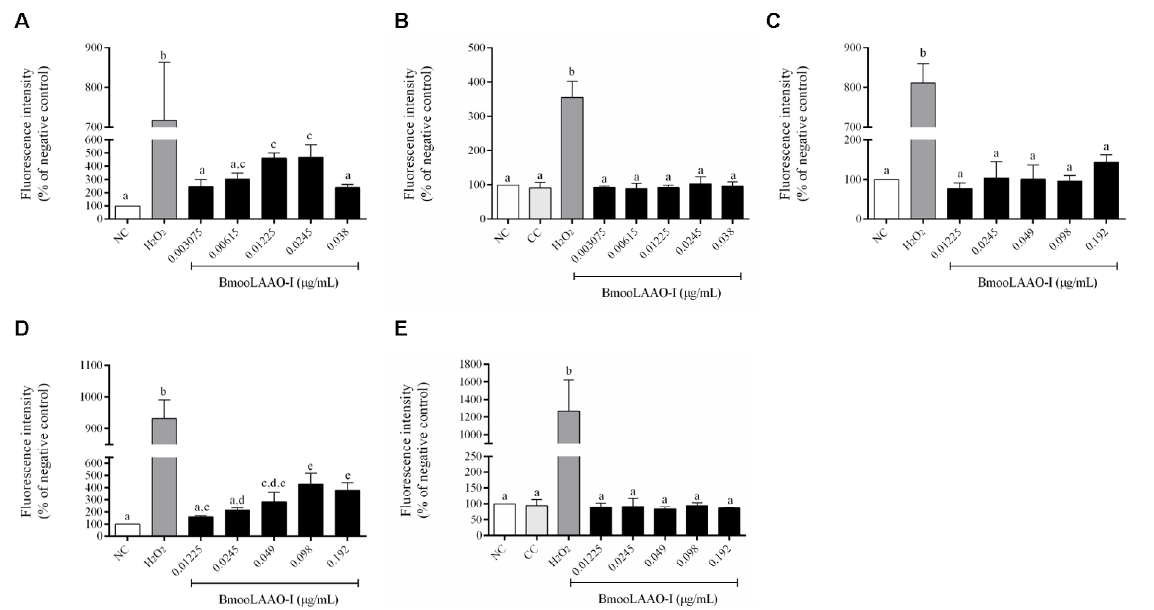
DCFDA was measured in HL-60, (C) 2